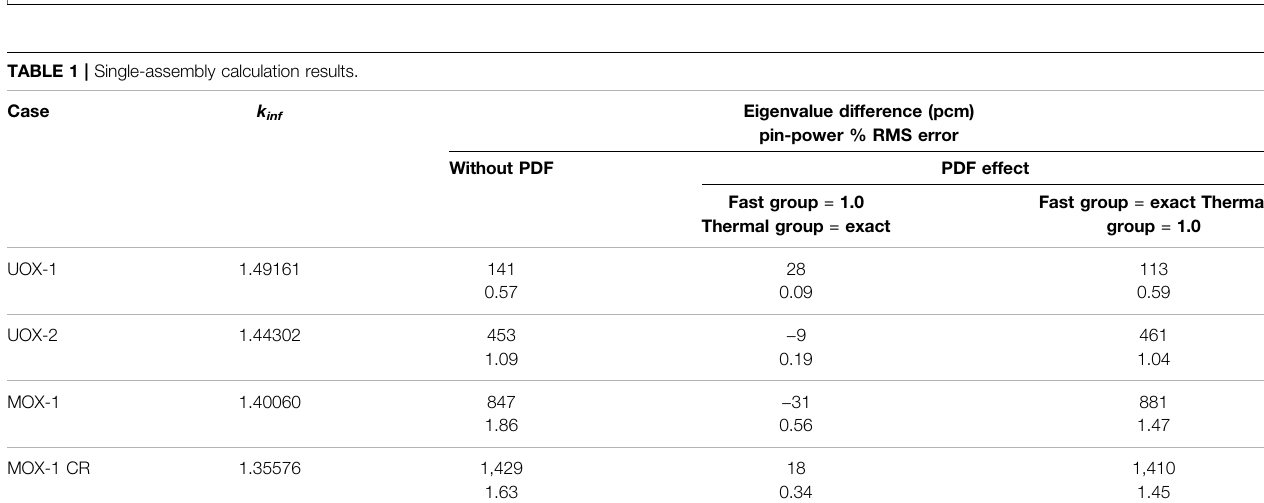
TABLE 1 | Single-assembly calculation